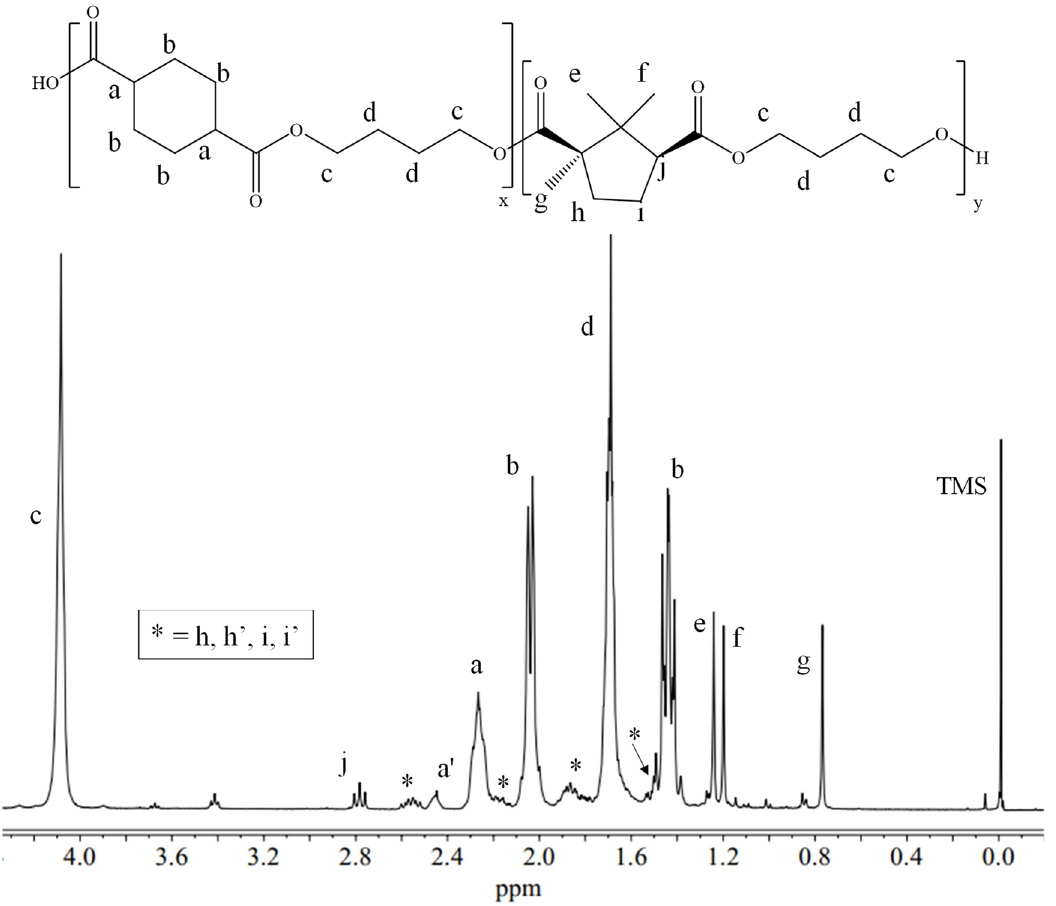
Figure 1. 1 H-NMR spectrum of P(BCE 85 BCE 15 ) copolymer with the corresponding peak assignment. Table 1. Molecular characterization data of the PBCE homopolymer and P(BCE x BC y ) copolymers. BCE Polymer